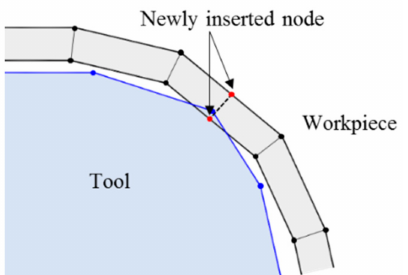
Figure 5. Penetration of a newly inserted node into the tool